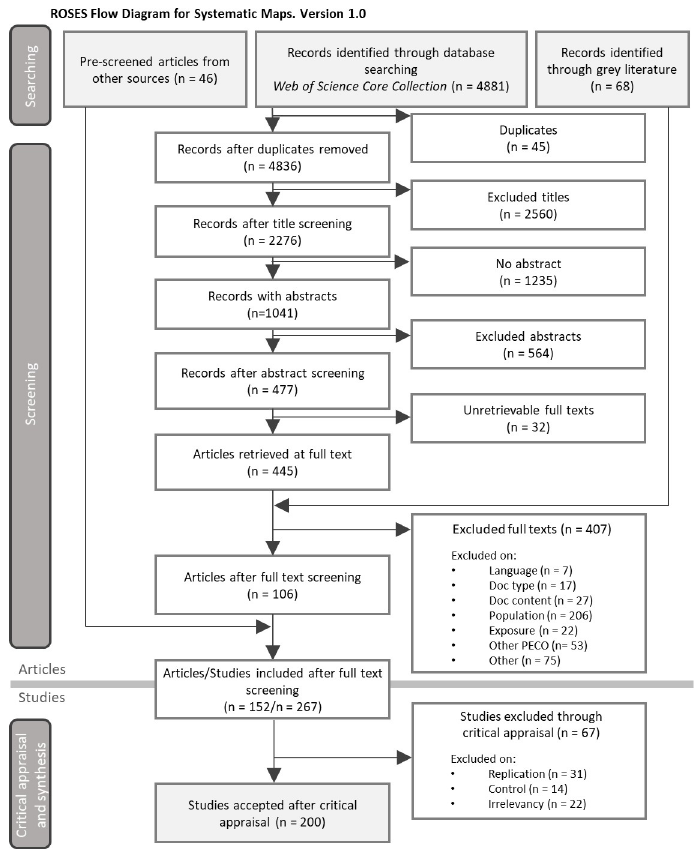
Fig 1. ROSES flow diagram reporting the screening process of the articles and studies of the review